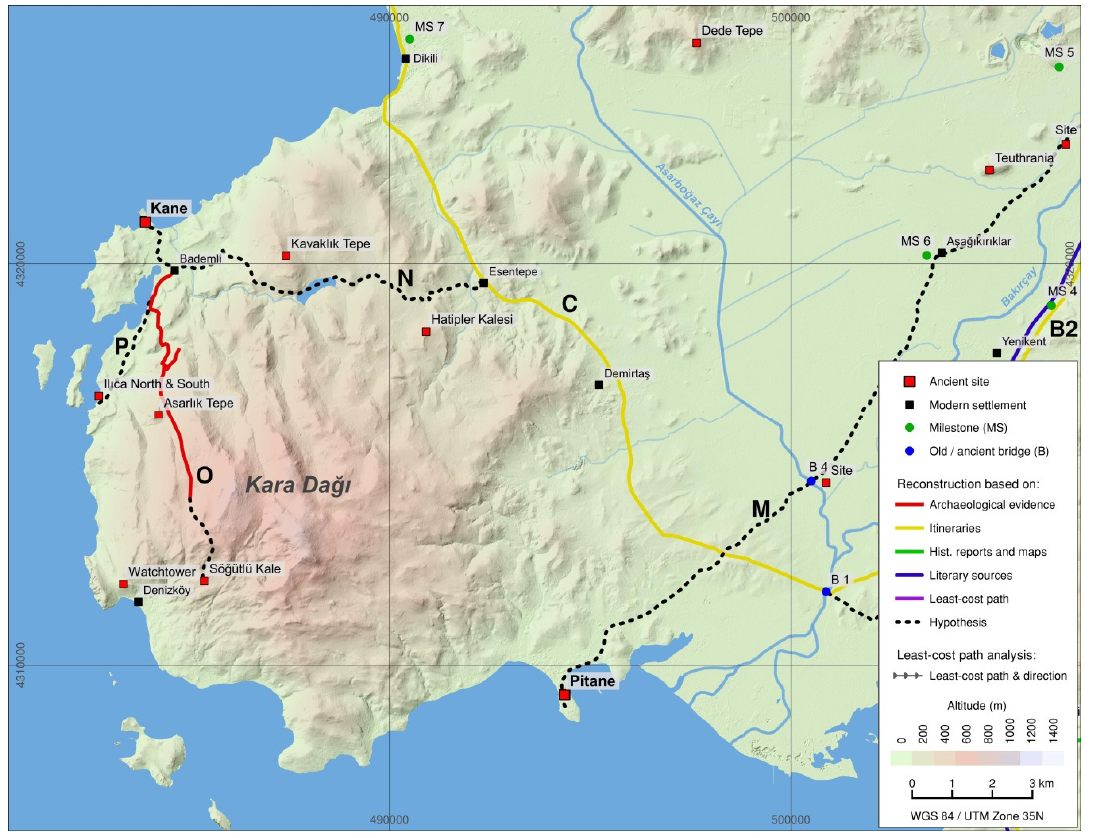
Figure 25. Reconstructed routes between Kane and the ancient coastal road and from Kane to the Kara Da ğ ı Mountains.